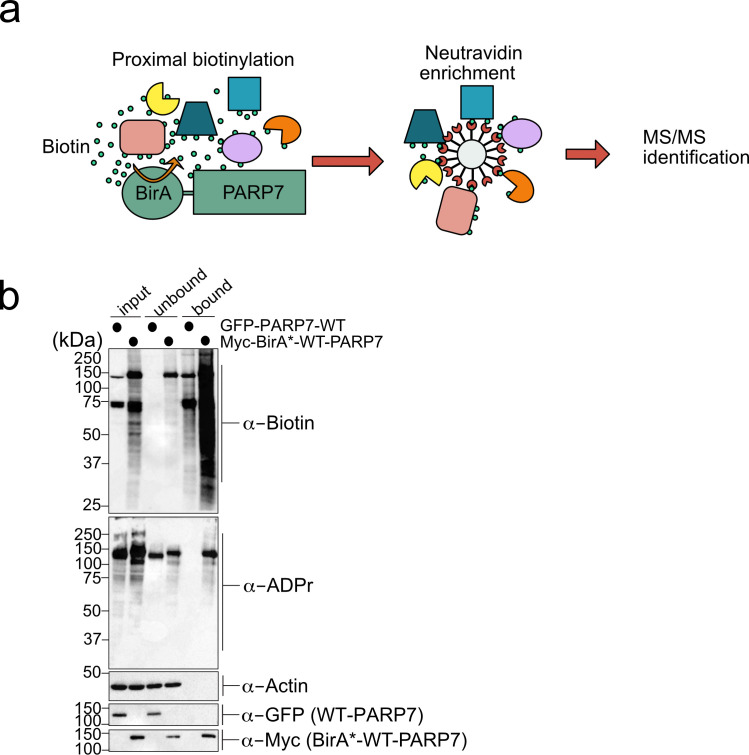
A proximity labeling approach identifies intracellular interactors of PARP-7.(a) Schematic of proximity labeling approach (referred to as BioID) for identifying interacting proteins of PARP-7 in cells. (b) Proximity labeling of PARP-7 interactors in cells. Myc-BirA*-WT-PARP-7 or GFP-WT-PARP-7 were expressed in HEK 293 T cells (GFP-WT-PARP-7 is used as a negative control). Cells were treated with media supplemented with 50 μM biotin overnight. Neutravidin agarose was used to enrich biotinylated proteins (bound). Proteins were resolved by SDS-PAGE and were detected by Western blot using Strep-HRP (biotin) and an antibody against GFP.